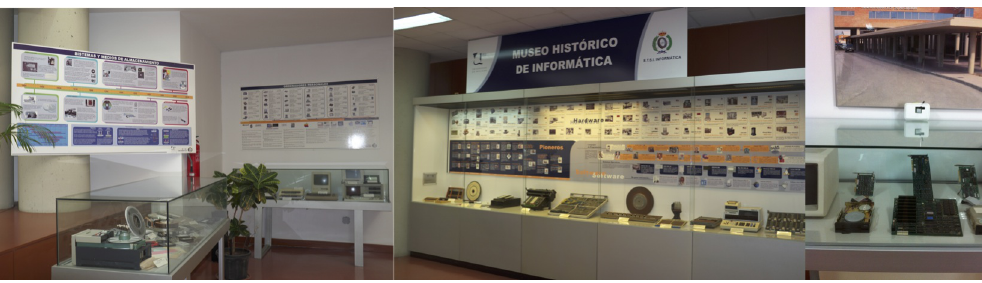
Figure 2. Snapshot of showcases in a Type 1 room in the Museum of Informatics.